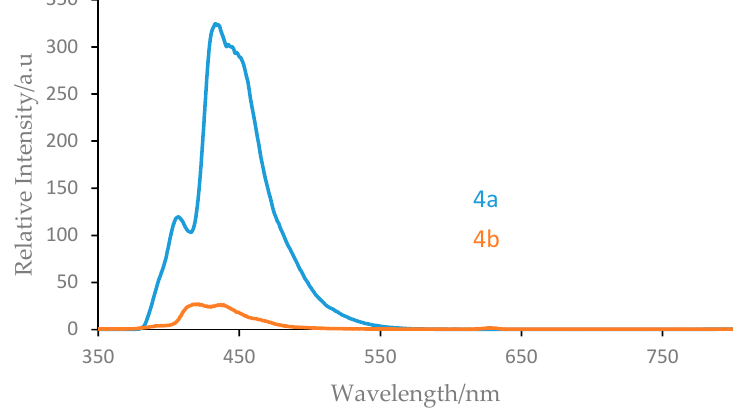
Figure 6. Emission spectra of the molecules 4a and 4b .